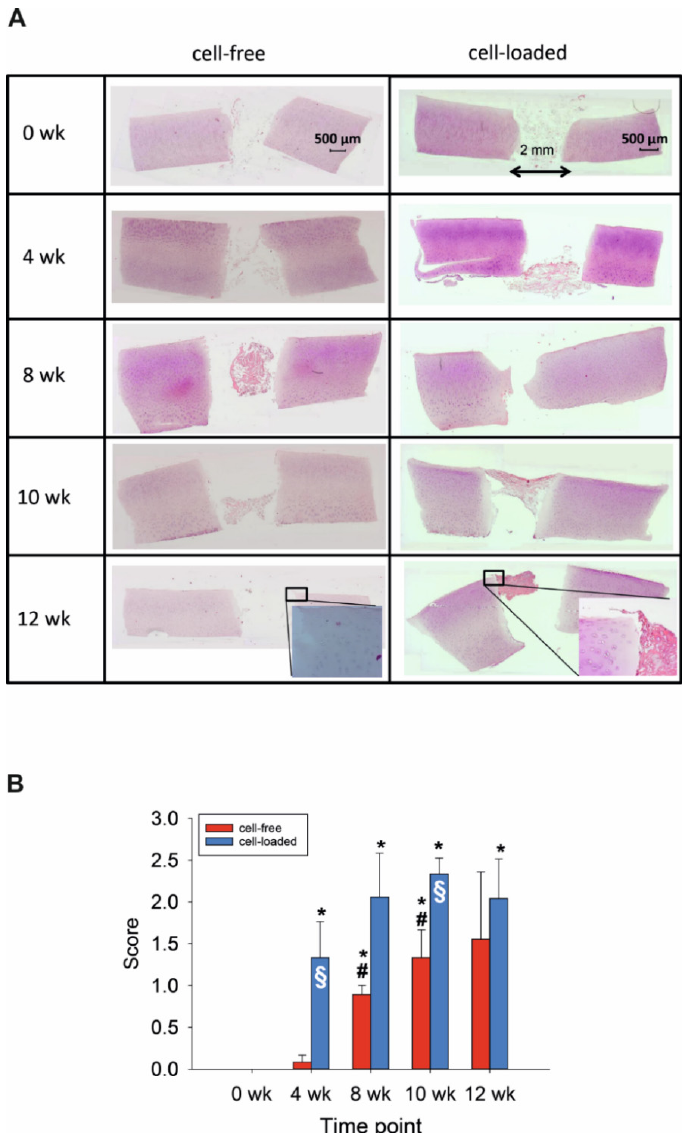
Figure 1. ( A ) Hematoxylin/eosin (HE) staining of the cartilage/PGA hybrids (+/ − cells) during in vitro culture. ( B ) Semiquantitation of PGA colonization (+/ − cells). Degree of migration: 0 = implant without cells; 1 = single adherent cells; 2 = several adherent cells; 3 = cell-layer on implant; means +/ − standard error of the mean; p ≤ 0.05 versus: * 0 weeks; or # 4 weeks; § versus